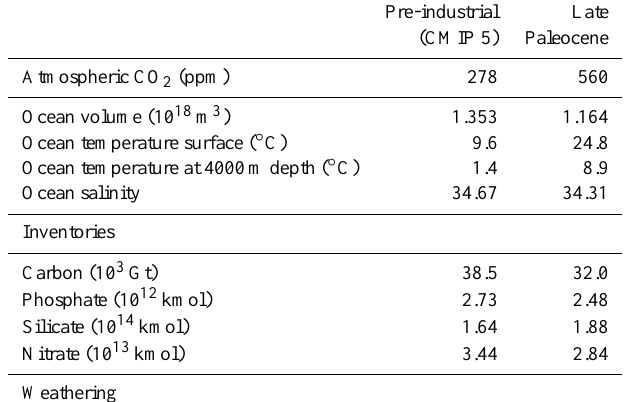
Fig. 1. Paleocene topography (m depth). Table 1. Globally integrated values of biogeochemical parameters calculated with HAMOCC for the pre-industrial (CMIP5, Ilyina et al., 2013) and the late Paleocene.